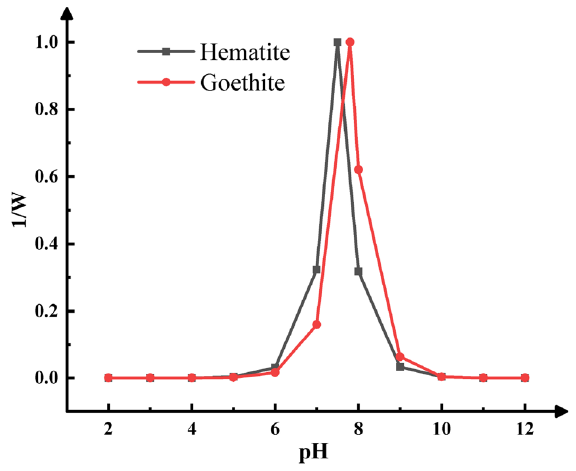
Figure 3. The attachment efficiency (1/ W ) of hematite and goethite nanoparticles in suspensions with different pH obtained by this model.